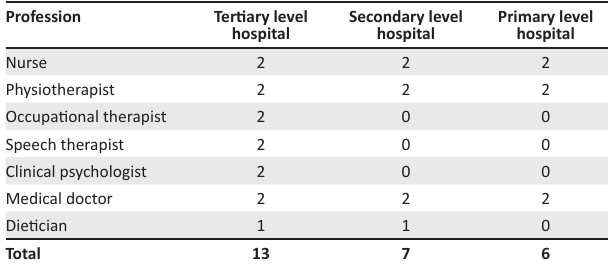
TABLE 1: Profession of